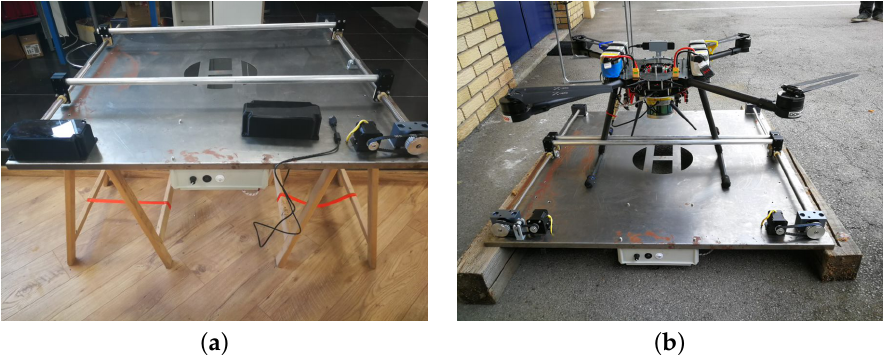
Figure 12. Test setups for the landing platform. ( a ) Test setup in the laboratory with a control box. ( b ) Outdoor test setup with manual landing of the LAAR and semi-automatic control of the LP in Zagreb,